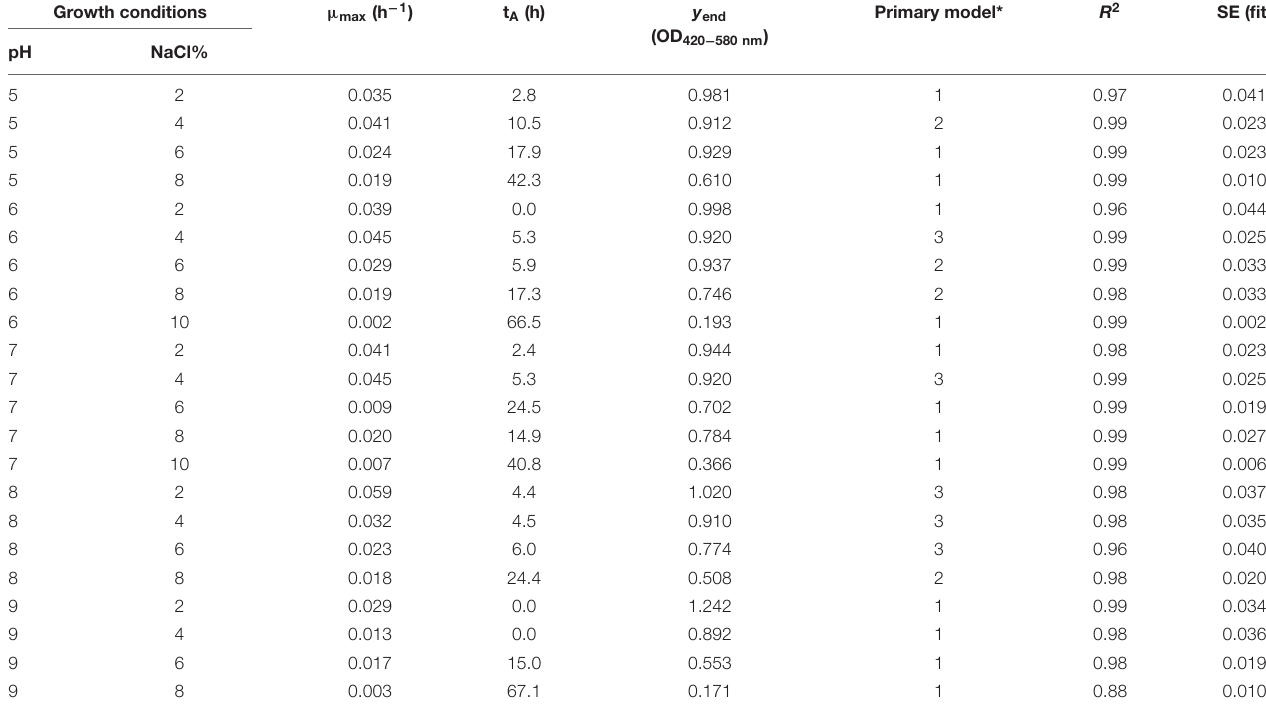
TABLE 1 | Kinetic parameters of the growth models of Vibrio spp. in ASPW. Growth